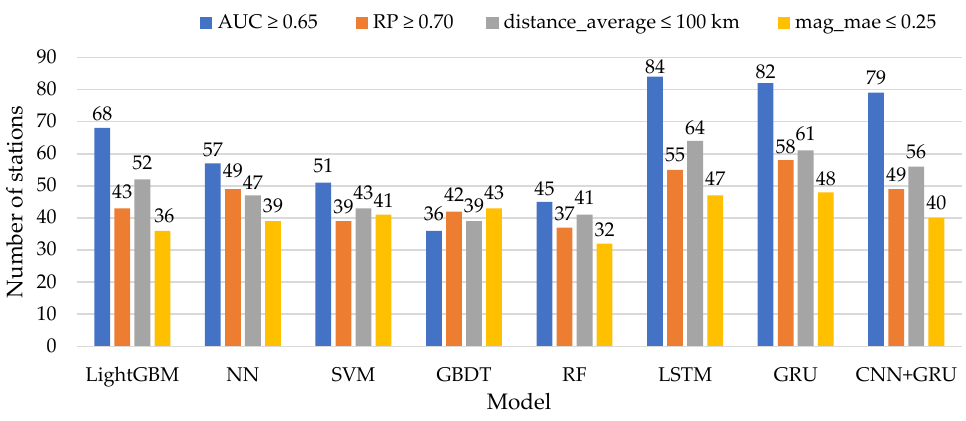
Figure 10. Overall results of the eight prediction models.